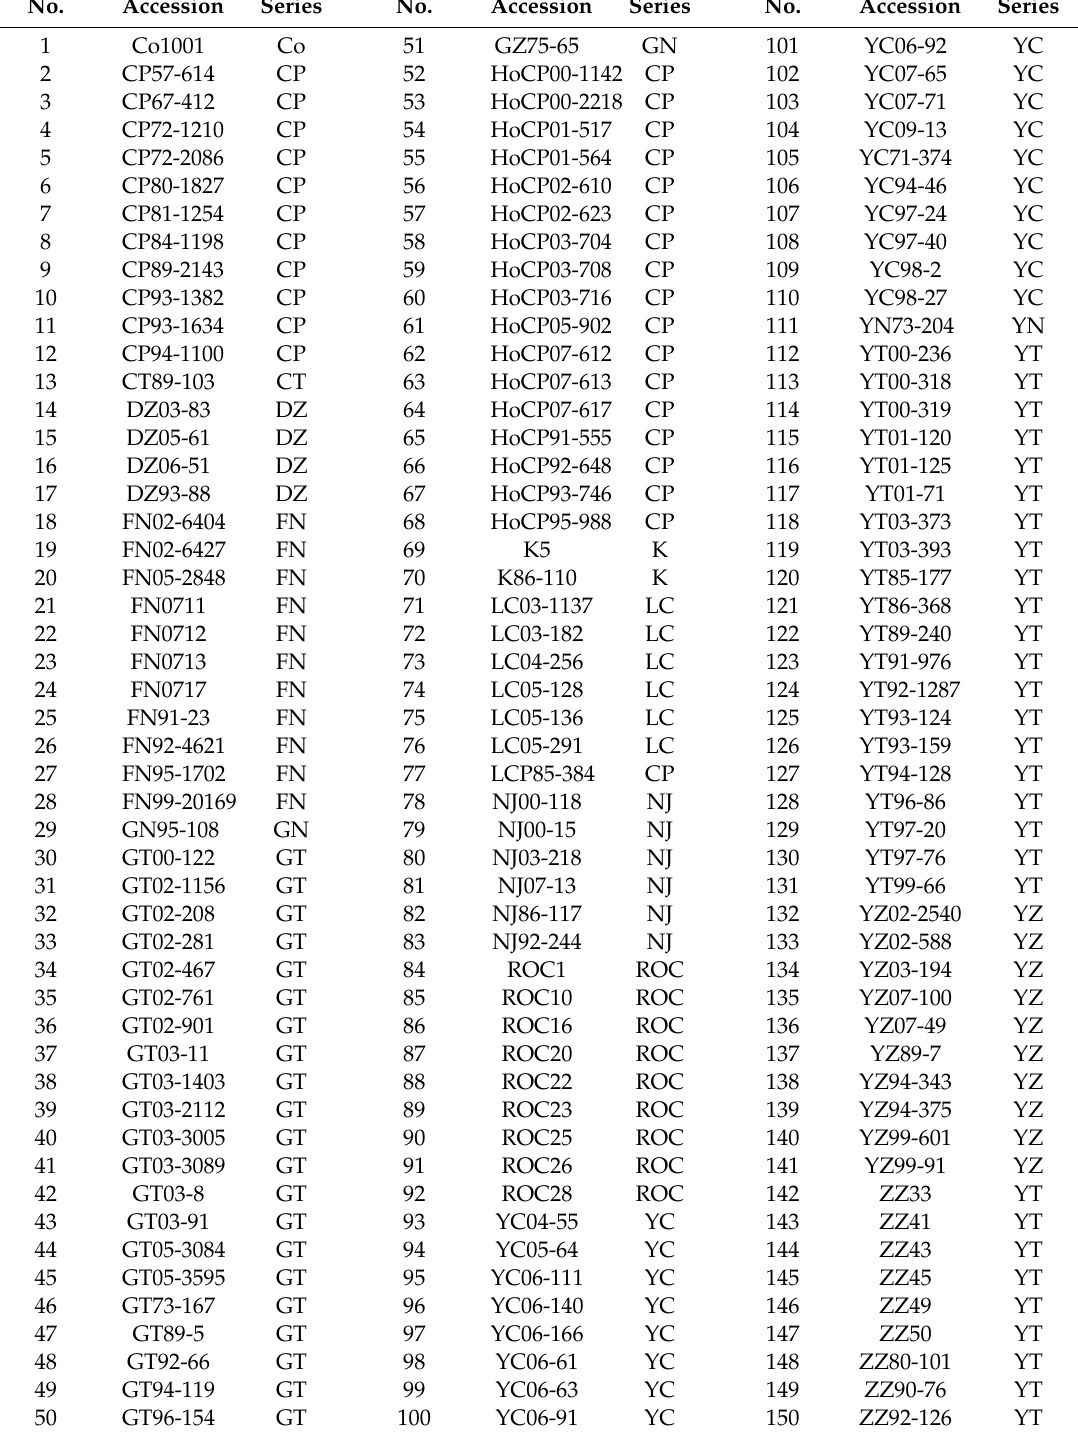
Table 1. The 150 sugarcane accessions used in the